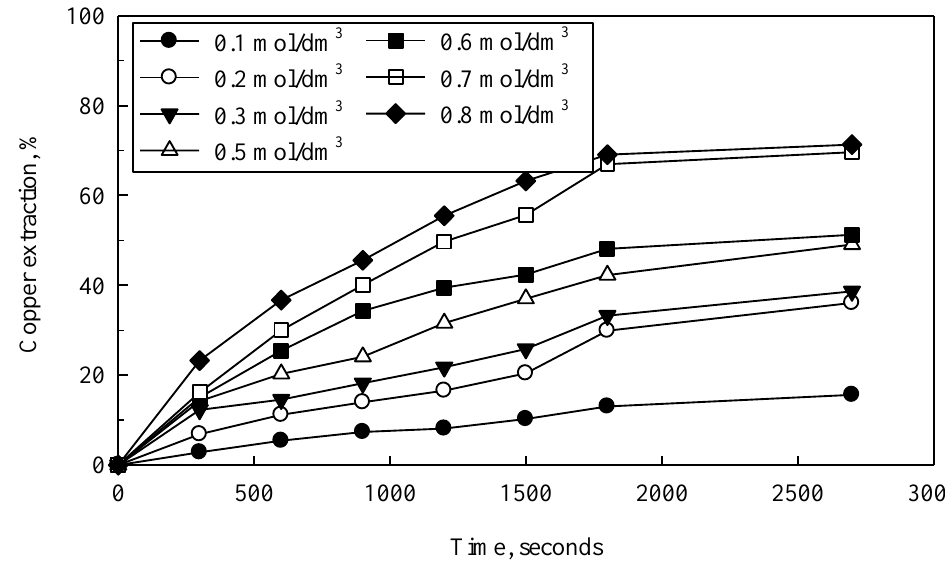
Figure 9. Effect of NH 4 OH concentration on converter slag leach rate. Working conditions: pH = 10.5, T = 298 K, PS = 64 µ m, Agitation = 500 rpm, ratio = 1000 / 1.